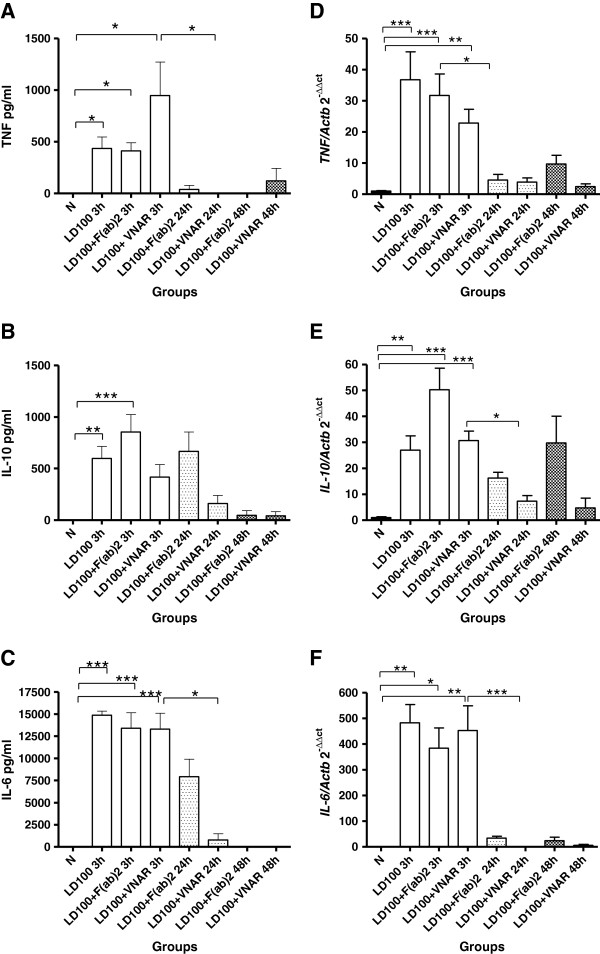
Production and expression of TNF, IL-6 and IL-10. Panels A, B, and C show levels of cytokines in serum of groups LD100, LD100 + VNAR or LD100 + F(ab)2 at different times; while panels D, E, and F show the expression in liver of the same cytokines at same groups and times; data represent mean ± standard error. The differences among groups were determined using a Kruskal-Wallis test and post hoc analysis using a Dunn’s multiple comparison test; differences were considered significant when *p < 0.05, **p < 0.01, ***p < 0.001. N = 10 animals for each group and time point.